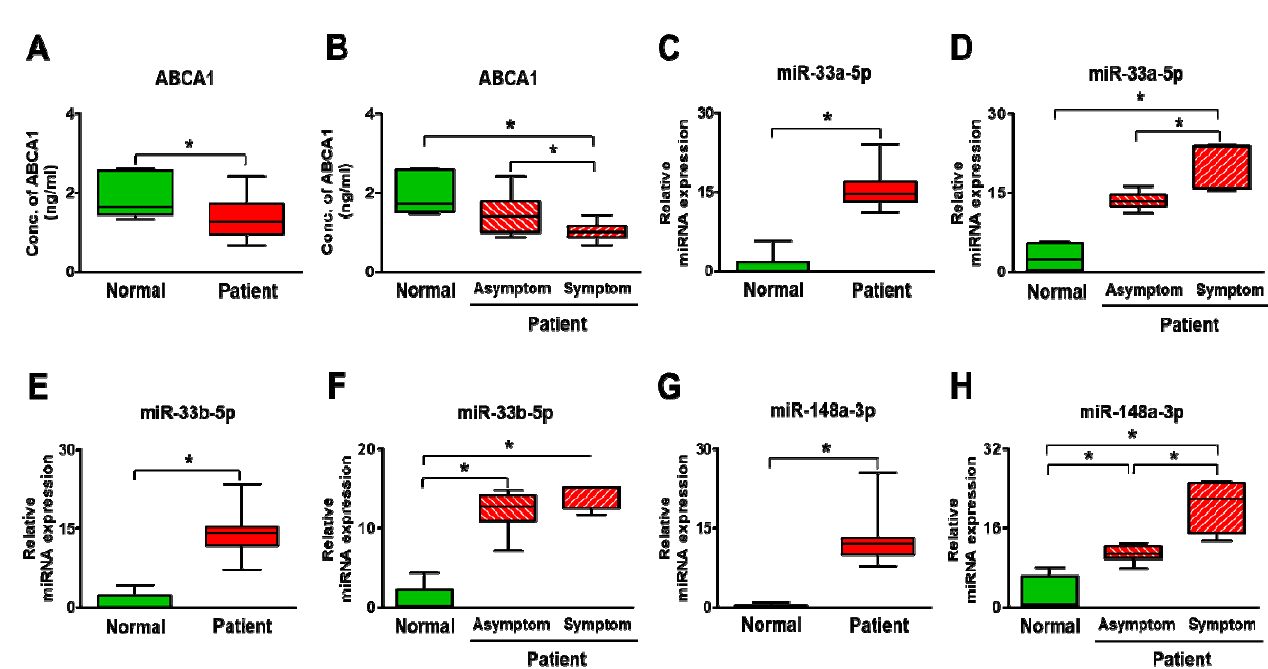
Figure 6. Expression of ABCA1 and its target miRNAs in the plasma of carotid artery stenosis patients. ( A , B ) Expression of soluble ABCA1 by ELISA. Expression of miR-33a-5p ( C , D ), miR-33b-5p ( E , F ), and miR-148a-3p ( G , H ) by qRT-PCR. Mean ± SD; * p < 0.05; t -test or One-way ANOVA. Normal, plasma of non-carotid artery stenosis patient; Patient, plasma of carotid artery stenosis patient.